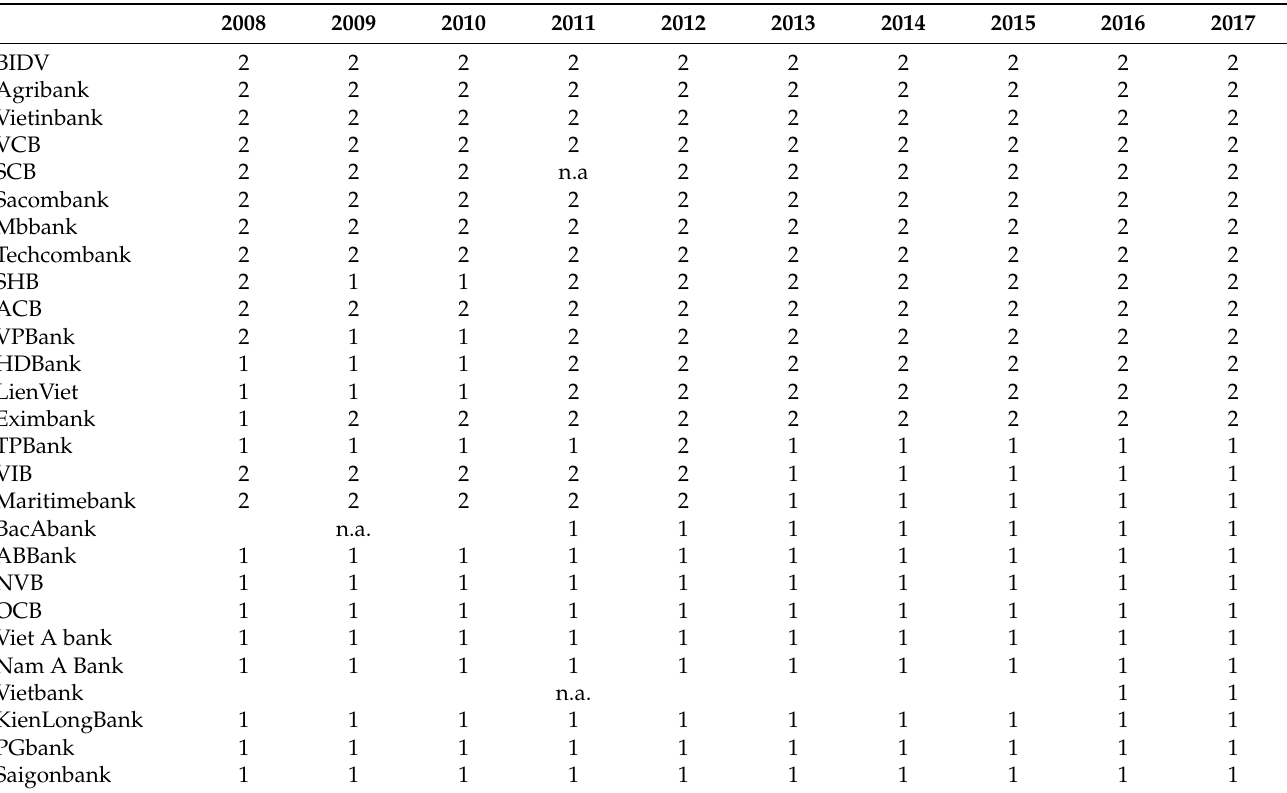
Table 1. Bank group one and two results for the sampled banks for the period 2008 to